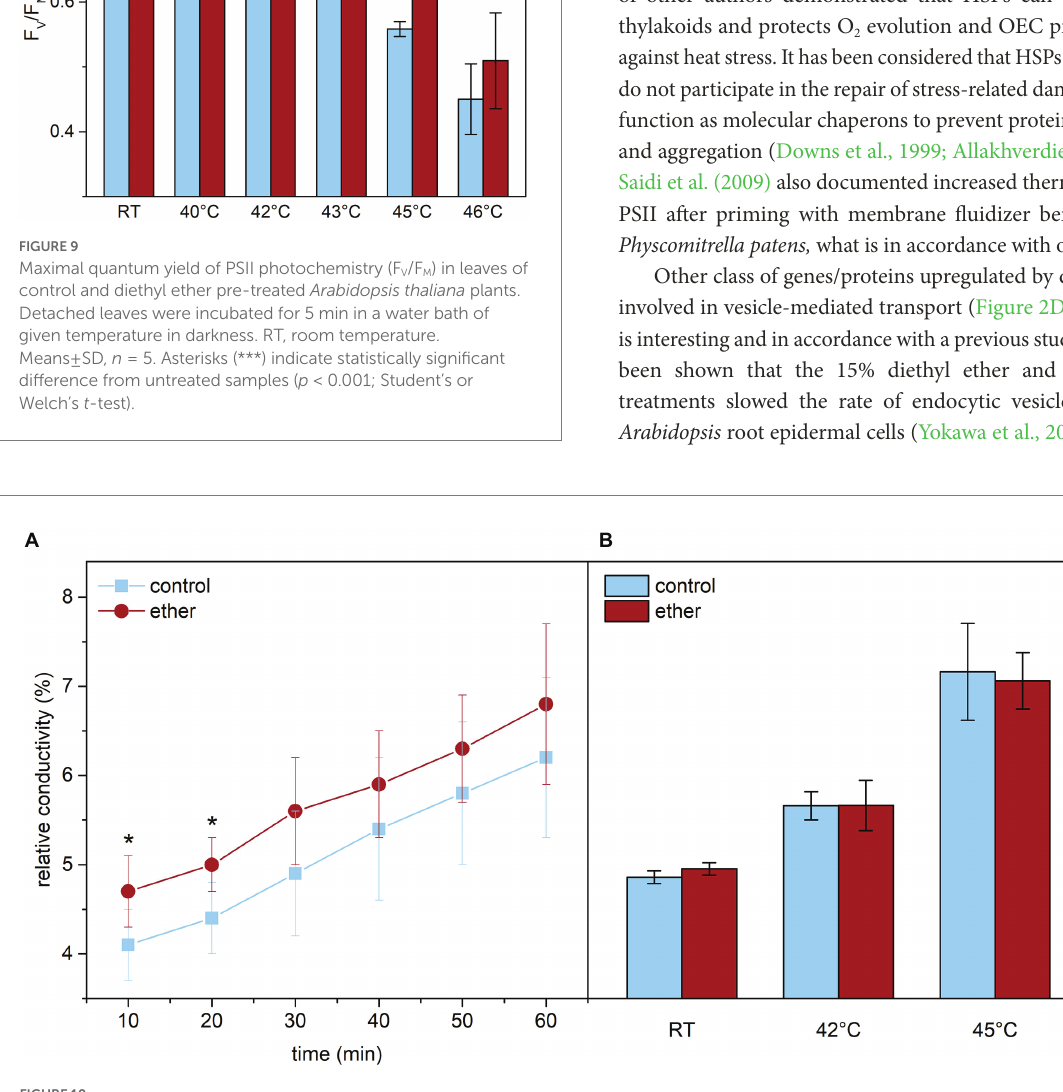
FIGURE 10 Relative conductivity reflecting ion leakage from leaf samples of Arabidopsis thaliana . (A) Relative conductivity at room temperature (RT) measured in 10 min intervals immediately after diethyl ether treatment and in control samples. (B) Relative conductivity after 60 min incubation of leaf samples at given temperature. Expressed in % of maximum conductivity measured in leaf samples with fully disintegrated membranes. Means ± SD, n = 5. Asterisks (*) indicate statistically significant difference from untreated samples ( p < 0.05; Student’s or Welch’s t -test).